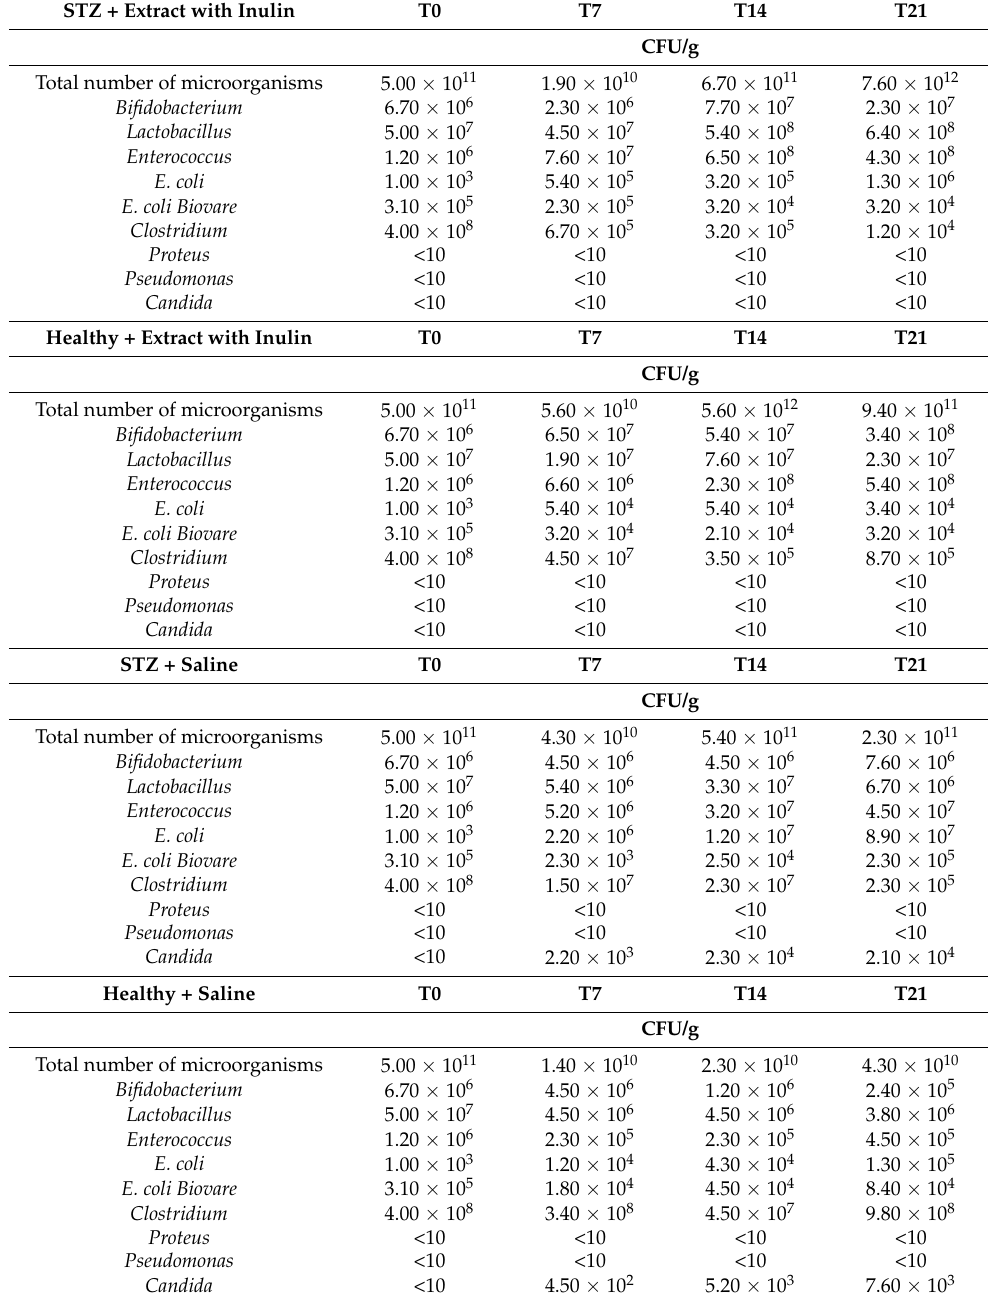
Table 5. Effect of Cornus mas fruit with inulin on the microbiological profile of the intestinal microor- ganisms in